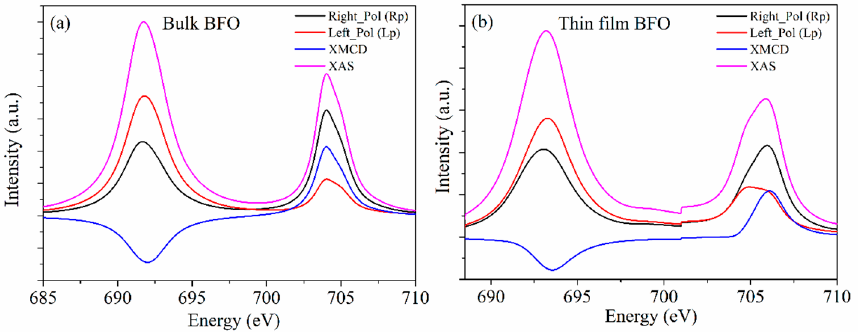
Figure 13. Absorption spectra at the Fe L 2,3 edges for right circular polarization (RP), left circular polarization (LP) of the exciting X-rays, X-ray magnetic circular dichroism (XMCD) and X-ray absorption spectra (XAS) in the ( a ) bulk, ( b ) thin film BiFeO 3 compound.